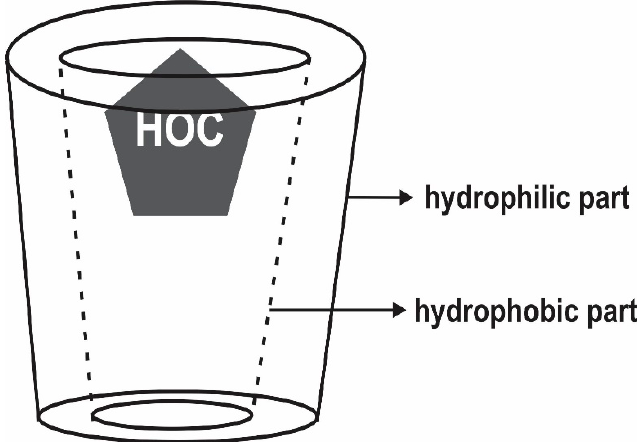
Figure 4. Inclusion complex formed by cyclodextrins (CDs) with hydrophobic organic compounds ( HOCs) during SW. Reprinted with the permission of [2].